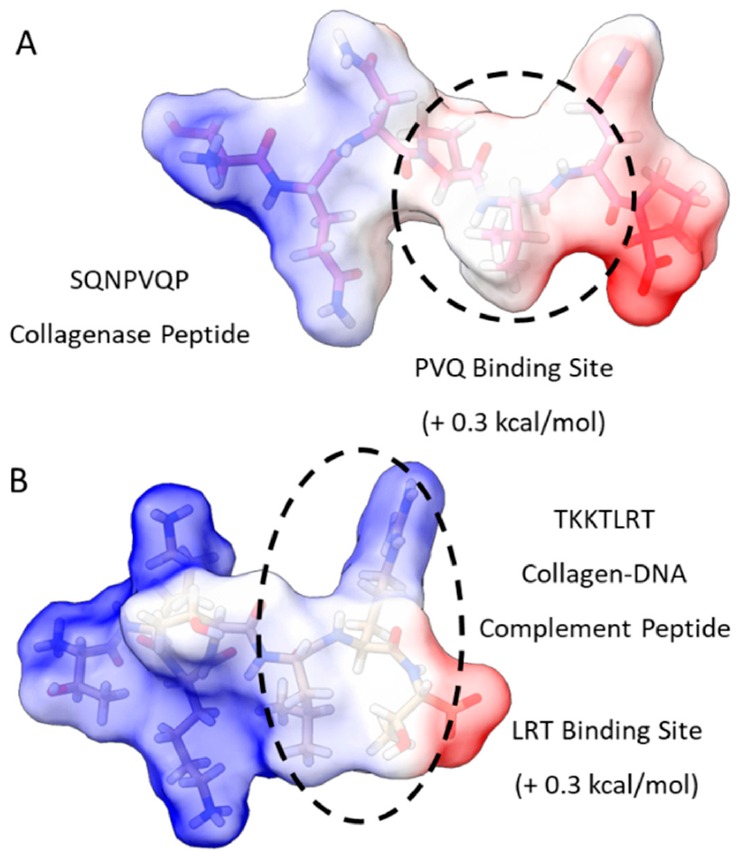
Figure 1. Free energy of binding estimates for sets of three adjacent residues for two different collagen-binding peptides (collagenase peptide ( A ) and collagen DNA-complement peptide ( B )) on human collagen type I alpha chain 2 (COL1A2) residues 861–871. Each circle represents a potential three-amino-acid binding site between a peptide and collagen as a result of the lowest predicted energy binding subsequence for each respective peptide. The potential binding free energy was calculated from the Wimley–White hydropathy scale values for the amino acids within the binding site.